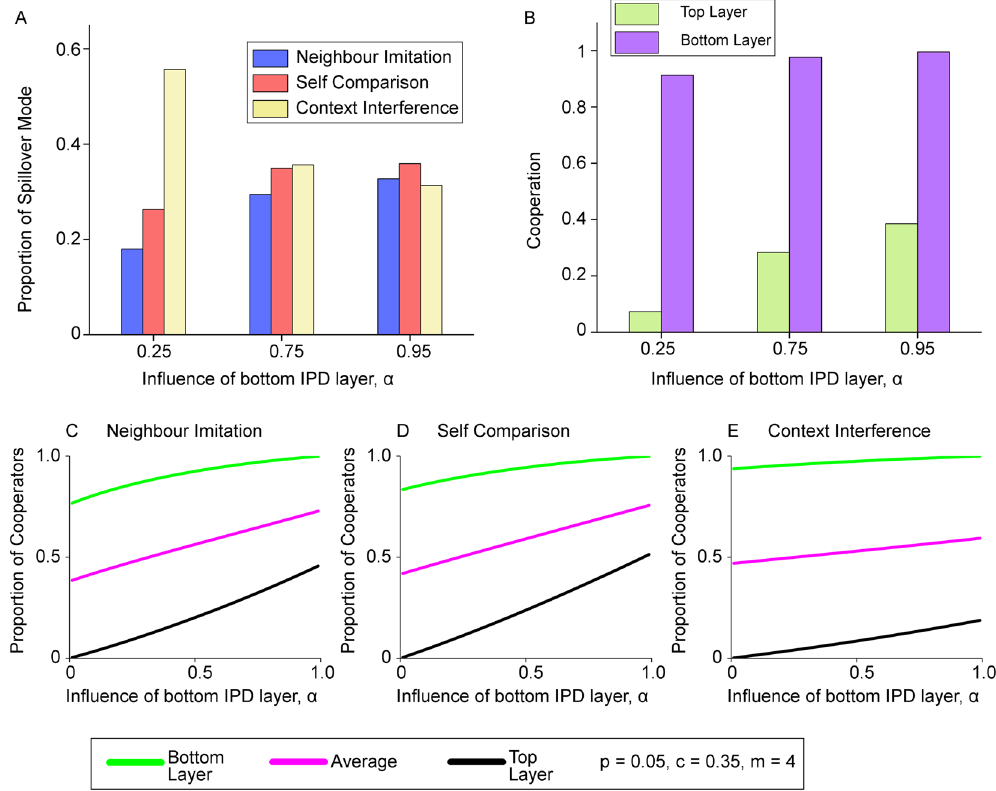
Figure 6. Uneven influence of multiplex layers in spillover process. Figure 6 shows the effect of varying parameter α ∈ (0, 1) which governs the relative influence of the two multiplex layers. ( A ) shows that as α increases, self comparison spillover mode can have the highest proportion instead. A high α allows repeated interactions in the bottom layer to have a large influence and creates more favourable conditions for cooperation in the top layer, as shown by ( B ). This allows for individuals cooperating on both layers, which is plentiful under SCS, to become competitive during coevolution. ( C – E ) shows how cooperation in the multiplex increases with α under each spillover mode. Context interference is seen to be most resilient against the effect of spillover. Parameters for ( A , B ) n = 400, m = 4, b = 1, c = 0.35, β = 0.2, p = 0.05. Mutation rate μ = 10 − 3 , at least 10 9 total time steps, combined from at most 10 runs. Parameters for ( C – E ) m = 4, b = 1, c = 0.35, β = 0.2, p = 0.05, generated using pair